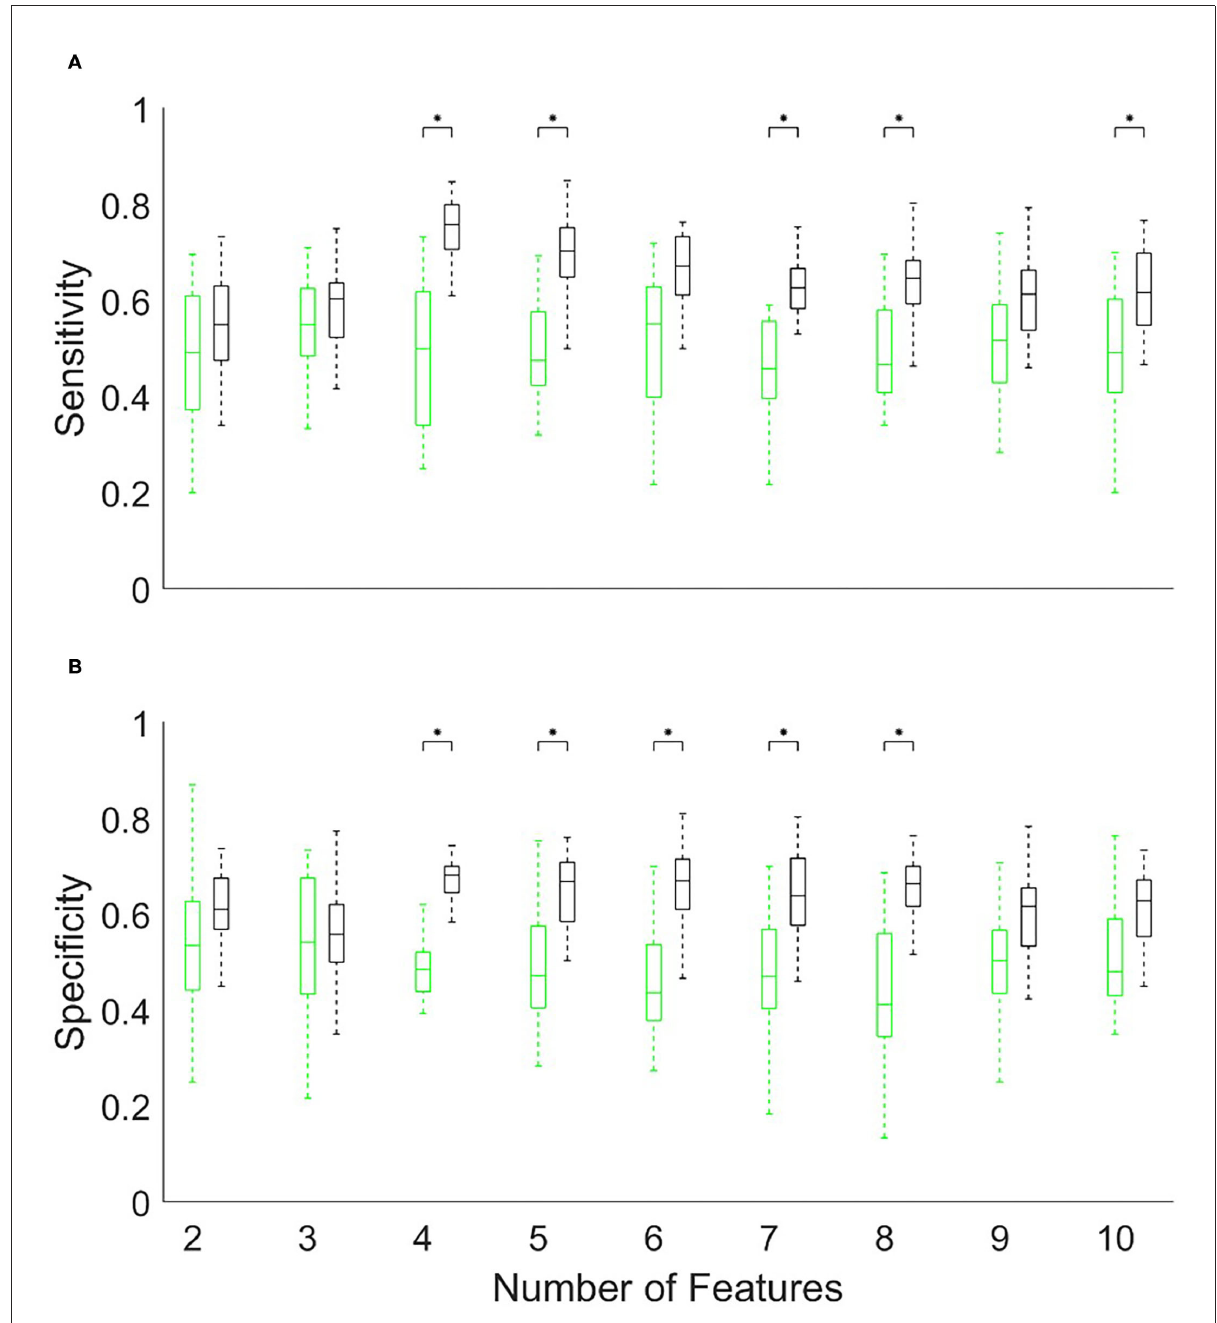
FIGURE3 The accuracy (A) sensitivity and (B) specificity of discriminating patients (N = 21) from normal subjects (N = 18) using the Support Vector Machine and a limited number (x-axis) of the top-ranked hemodynamic features. The accuracy is found from 5-fold cross-validation repeated 20 times with different randomly selected partitions. The black boxes indicate the accuracy and the green boxes indicate the corresponding null distribution calculated by randomly permuting the labels. Statistical significance calculated from the Kolmogorov–Smirnov test is indicated using an asterisk (*p < 0.05, Bonferroni corrected). The central mark in a box indicates the median, and the bottom and top edges of the box are the 25th and 75th percentiles, while the whiskers extend to the most extreme data points not considered